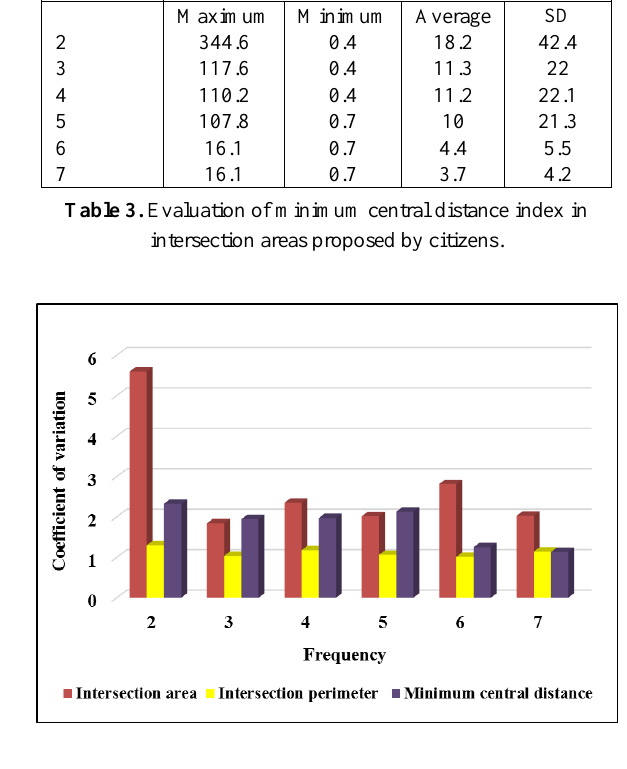
Figure 7. Coefficient of variation of spatial